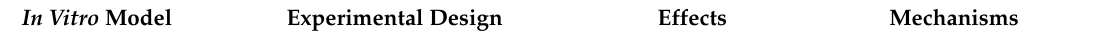
Table 3. Effects of fucoxanthin on NAFLD in cell